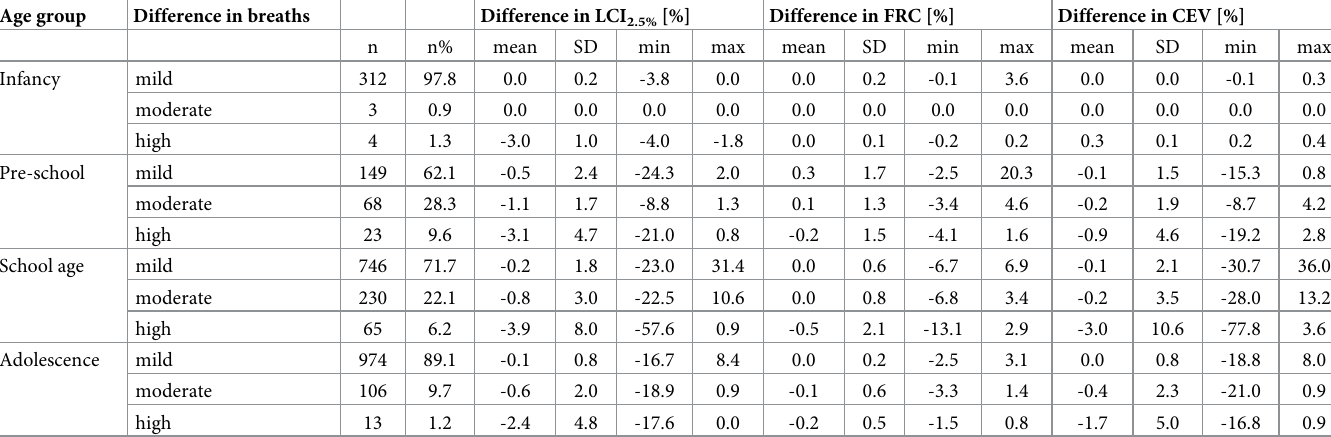
Table 2. Impact of breath-detection algorithms on main MBW outcomes. Relative difference (Spiroware–custom; mild ( < 5%), moderate (5 to 10%), high ( > 10%)) in main MBW outcomes (LCI, FRC, CEV) by age group (infants (0 to 2 years), pre-school age ( > 2 to 6 years), school age ( > 6 to 11 years), adolescents ( > 12 years)). Abbrevia- tions: LCI 2.5% : lung clearance index; FRC: functional residual capacity; CEV: cumulative expired